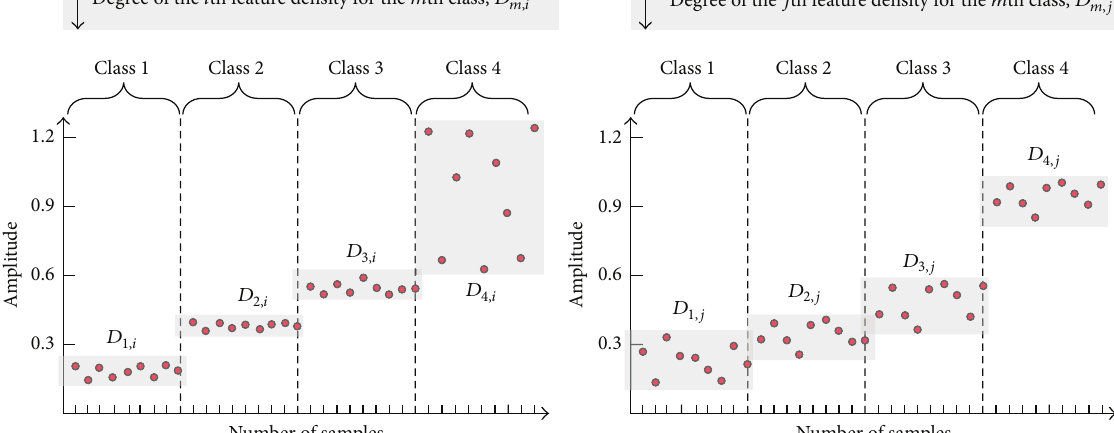
Figure 5: Examples of the 𝑖 th and 𝑗 th fault signature distribution per class with the assumption that these features have the same degrees of the interclass